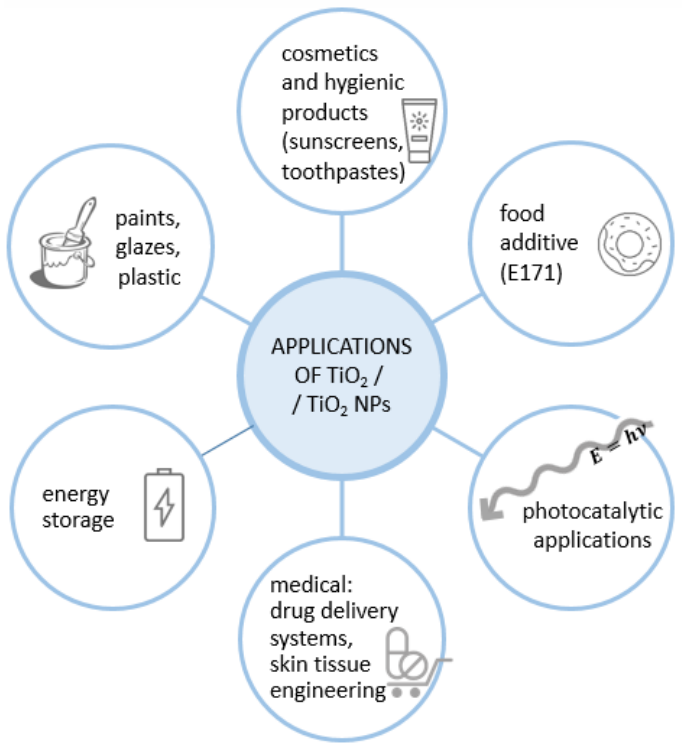
Figure 1. Various applications of titanium dioxide/titanium dioxide nanoparticles (TiO 2 /TiO 2 NPs).